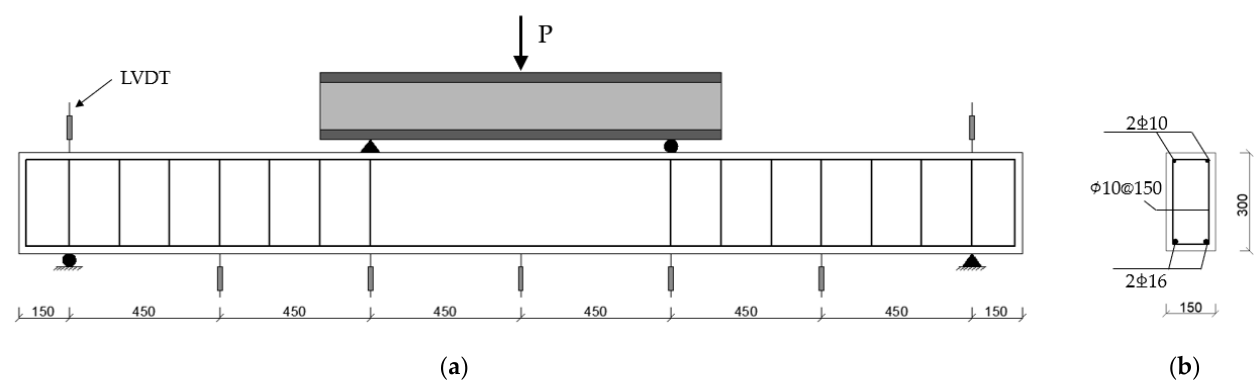
Figure 2. Details of test layout: ( a ) schematic view of the SFNMRC beam, loading configuration, and position of LVDT; ( b ) section and reinforcement details of test beams (unit: mm).